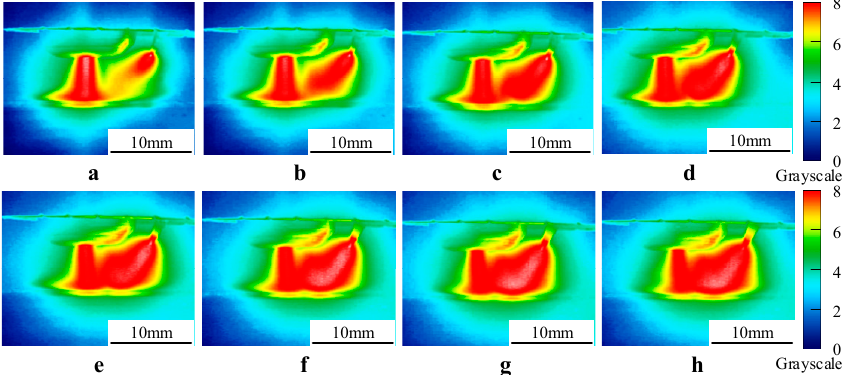
Figure 6. Acquired images of coupled arc profile with different plasma welding current. ( a ) 40 A; ( b ) 60 A; ( c ) 80 A; ( d ) 100 A; ( e ) 120 A; ( f ) 140 A; ( g ) 160 A; ( h ) 180 A.